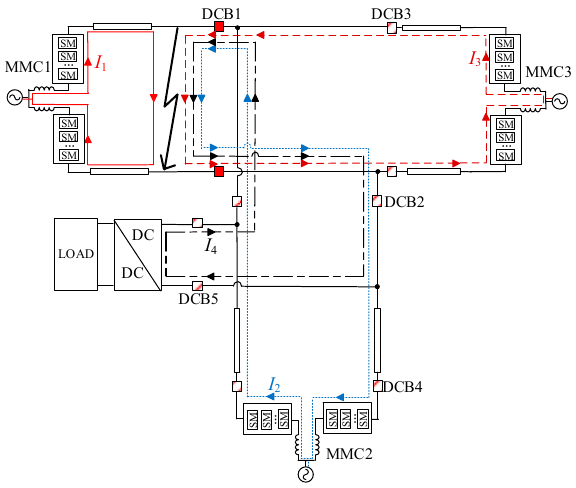
Figure 3. Equivalent circuit of pole ‐ to ‐ pole fault F2.